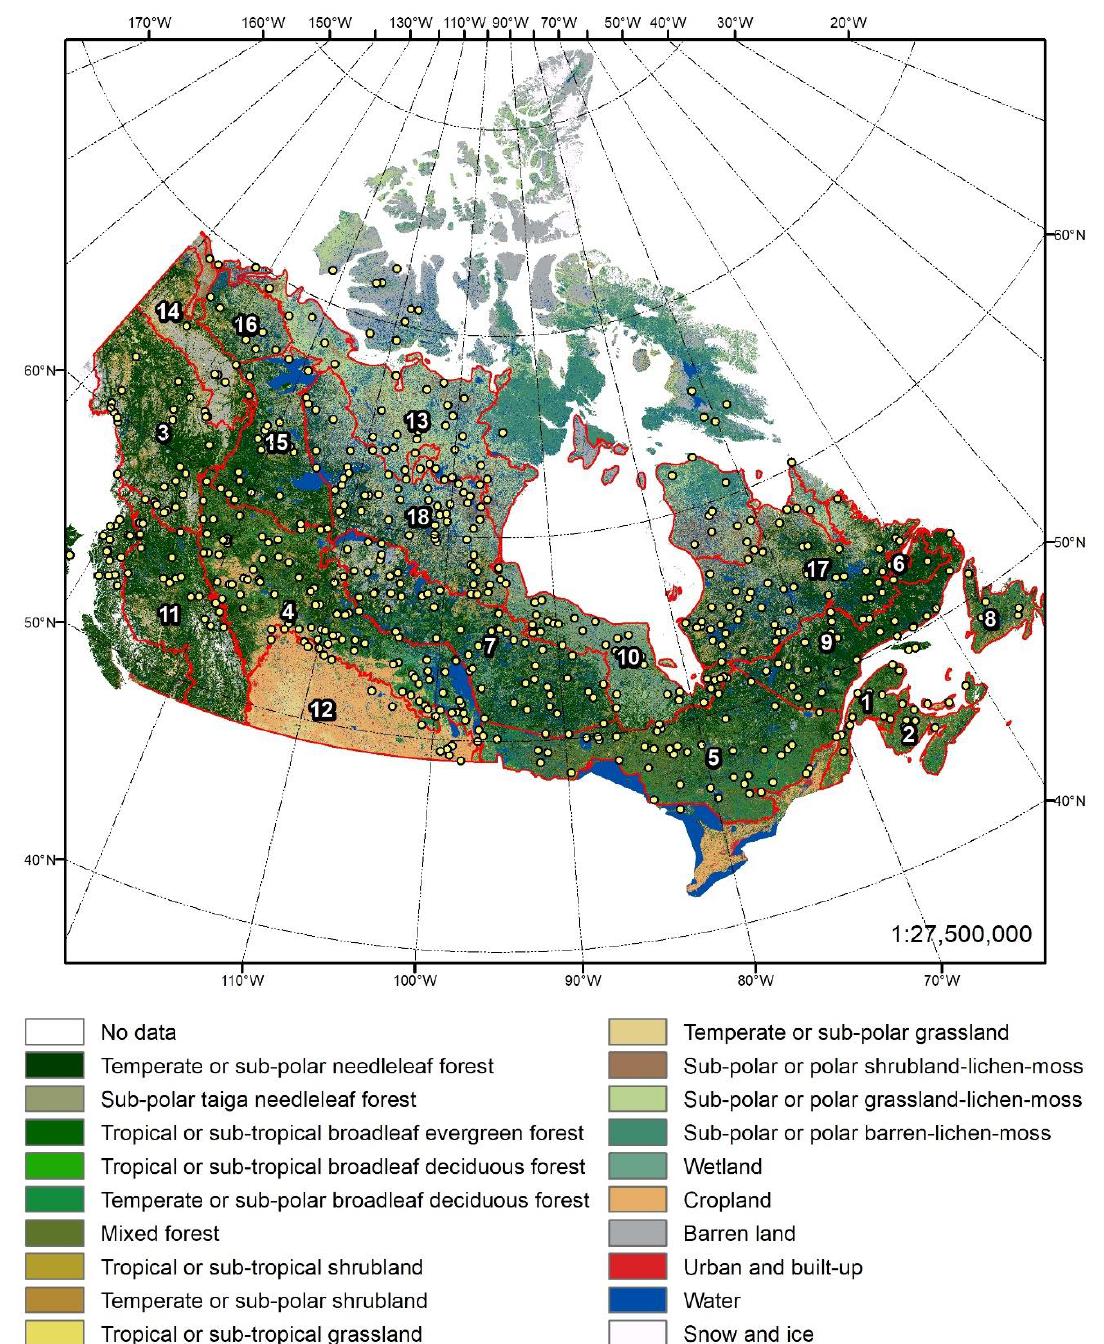
Figure 1. The 18 ecozones used in this study overlaid on the NALCMS (North America Land Change Monitoring System) land cover map of Canada. The yellow dots represent reference sample data sites used in this study.